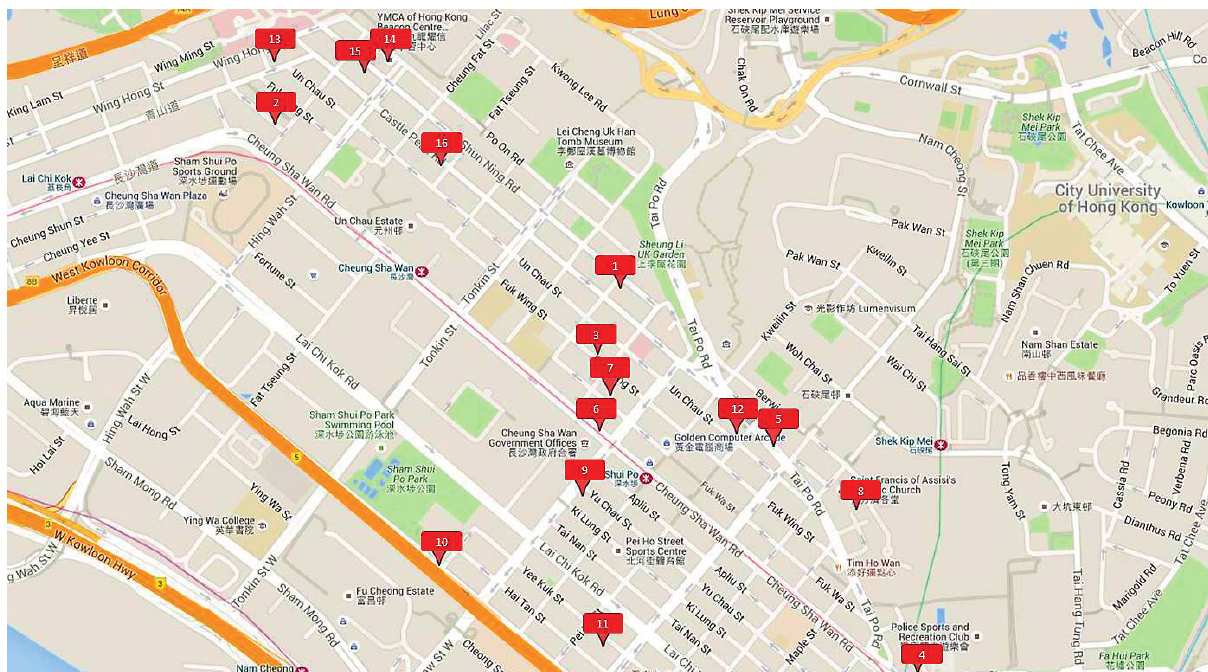
Fig. 4. Location of development in Sham Shui Po – Cheung Sha Wan district (Google Map 2015) Notes: 1 (The Met Delight), 2 (High One), 3 (High One Grand), 4 (High Park), 5 (High Point), 6 (Maison Rose), 7 (Vista), 8 (Gardenia), 9 (Milan Place), 10 (The Prominence), 11 (Hey Home), 12 (Court Regence), 13 (One New York), 14 (Beacon Lodge), 15 (Sorentino), and 16 (One Madison).